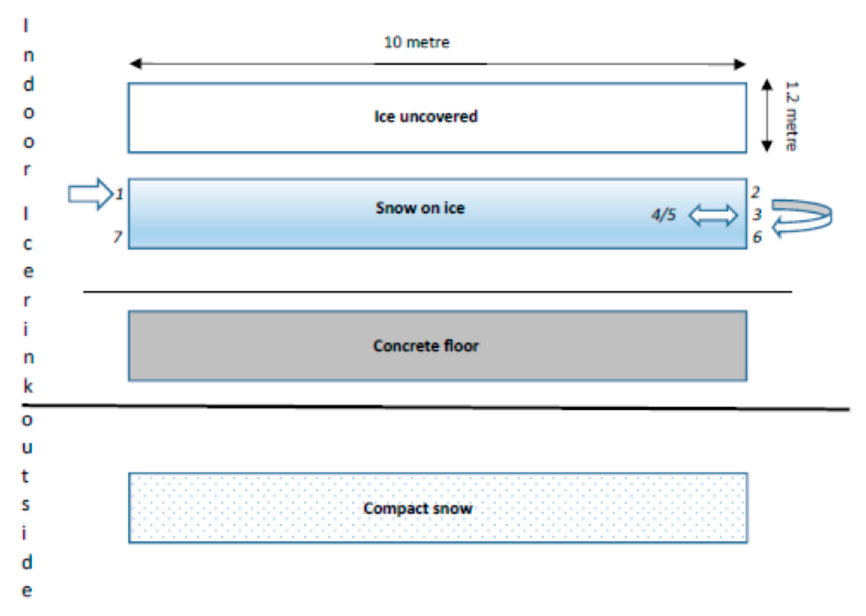
Figure 3. Sketch of the test tracks.